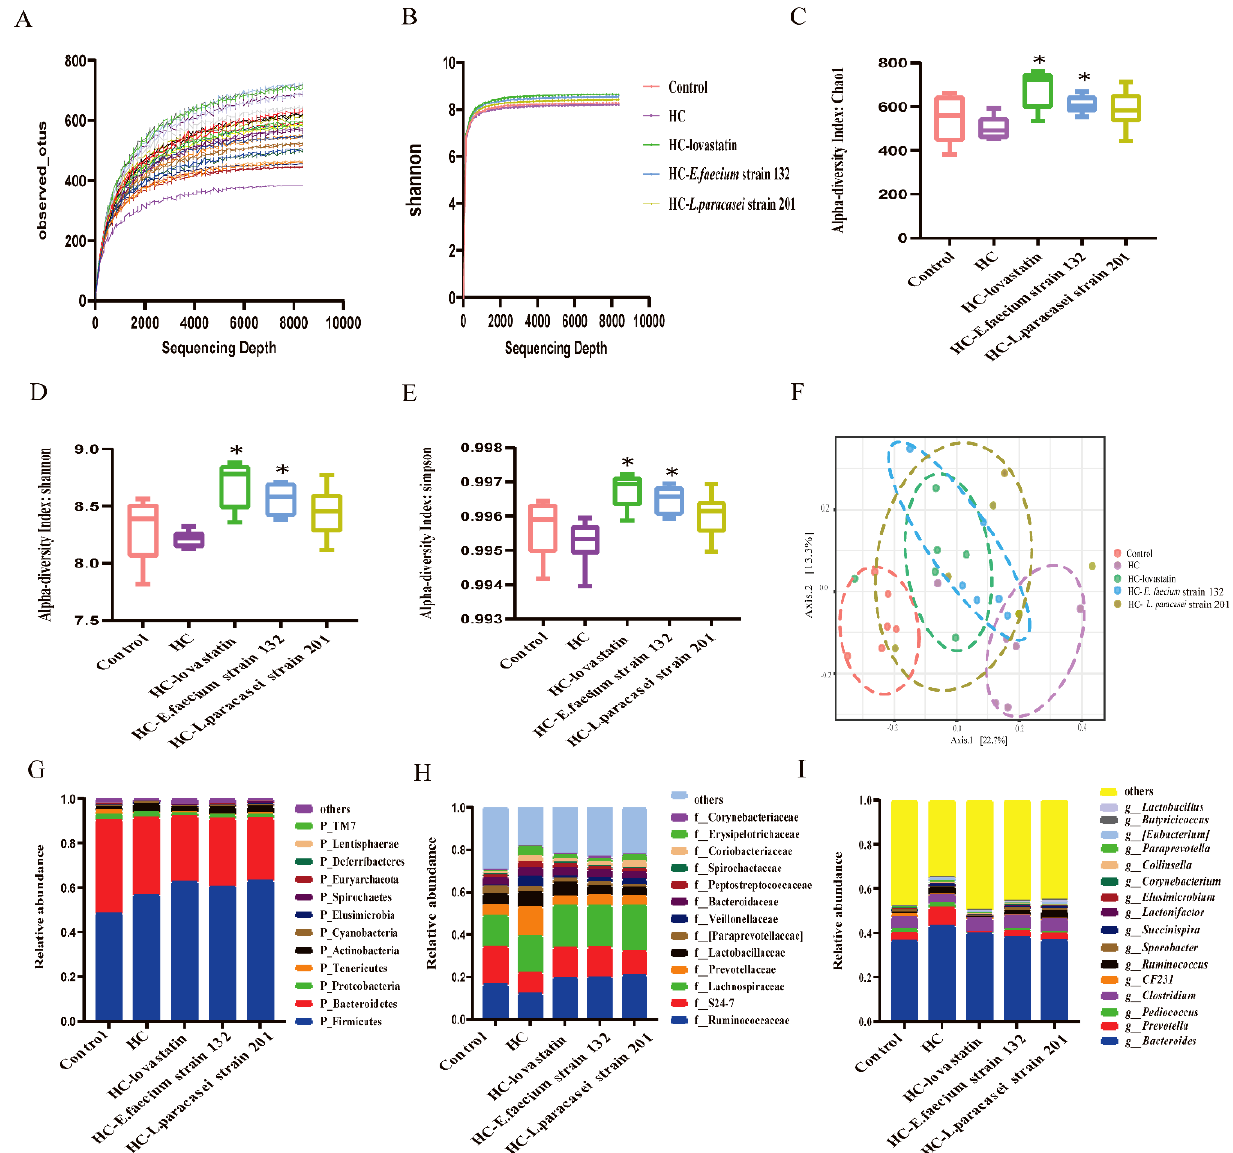
Figure 5. Rarefaction curve, alpha and beta diversity and the species abundance of phylum, family and genus levels. ( A ) Rarefaction curve based on observed_otus per sample ( B ) Rarefaction curve based on Shannon index per group. ( C ) Box plot of alpha diversity calculated by the Chao1 index. ( D ) Box plot of alpha diversity calculated by the Shannon index. ( E ) Box plot of alpha diversity calculated by the Simpson index. ( F ) Beta diversity calculated by Unweighted UniFrac Distance. ( G ) The relative abundance of phylum level. ( H ) The relative abundance of family level. ( I ) The relative abundance of genus level. The pink bar represents the control group, the purple bar represents the HC group, the green bar represents the HC-lovastatin group, the blue bar represents the HC- E. faecium strain 132 group and the yellowish-brown bar represents HC- L. paracasei strain 201group. A Kruskal–Wallis test was used to analyze the alpha diversity index, and the PERMANOVA test was used for beta diversity index analysis, n = 6. Significant differences in the HC-lovastatin, HC- E. faecium strain 132 or HC- L. paracasei strain 201 group versus HC group are indicated as * p < 0.05.